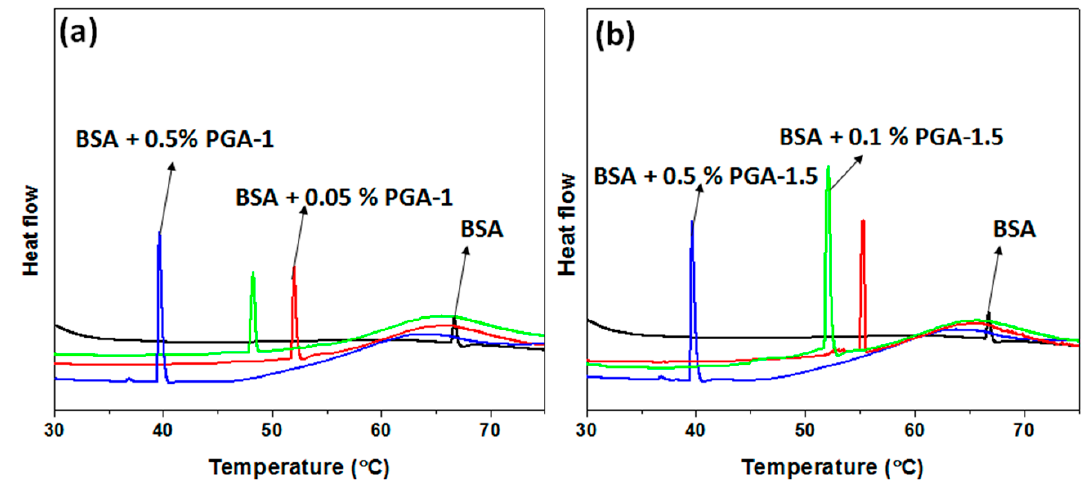
Figure 3. DSC thermograms of BSA in the absence and presence of PGA-1 ( a ) and PGA-1.5 ( b ) at various concentrations. The concentrations of the polymers are 0.05% (red line), 0.1% (green line), and 0.5% (blue line). Tm represents the highest point of relative heat.